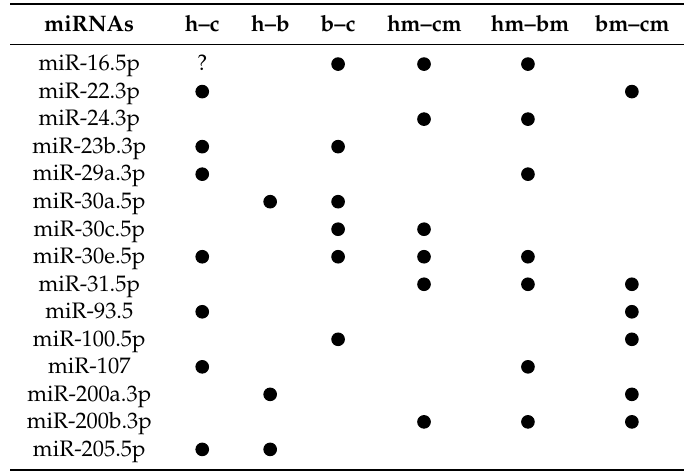
Table 2. The occurrence of individual miRNAs in pairs selected from the comparisons for urine supernatant and urine